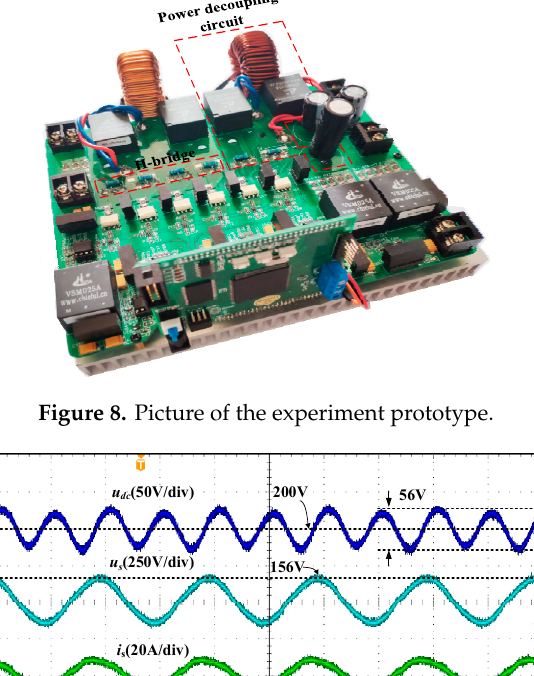
Figure 8. Picture of the experiment prototype.